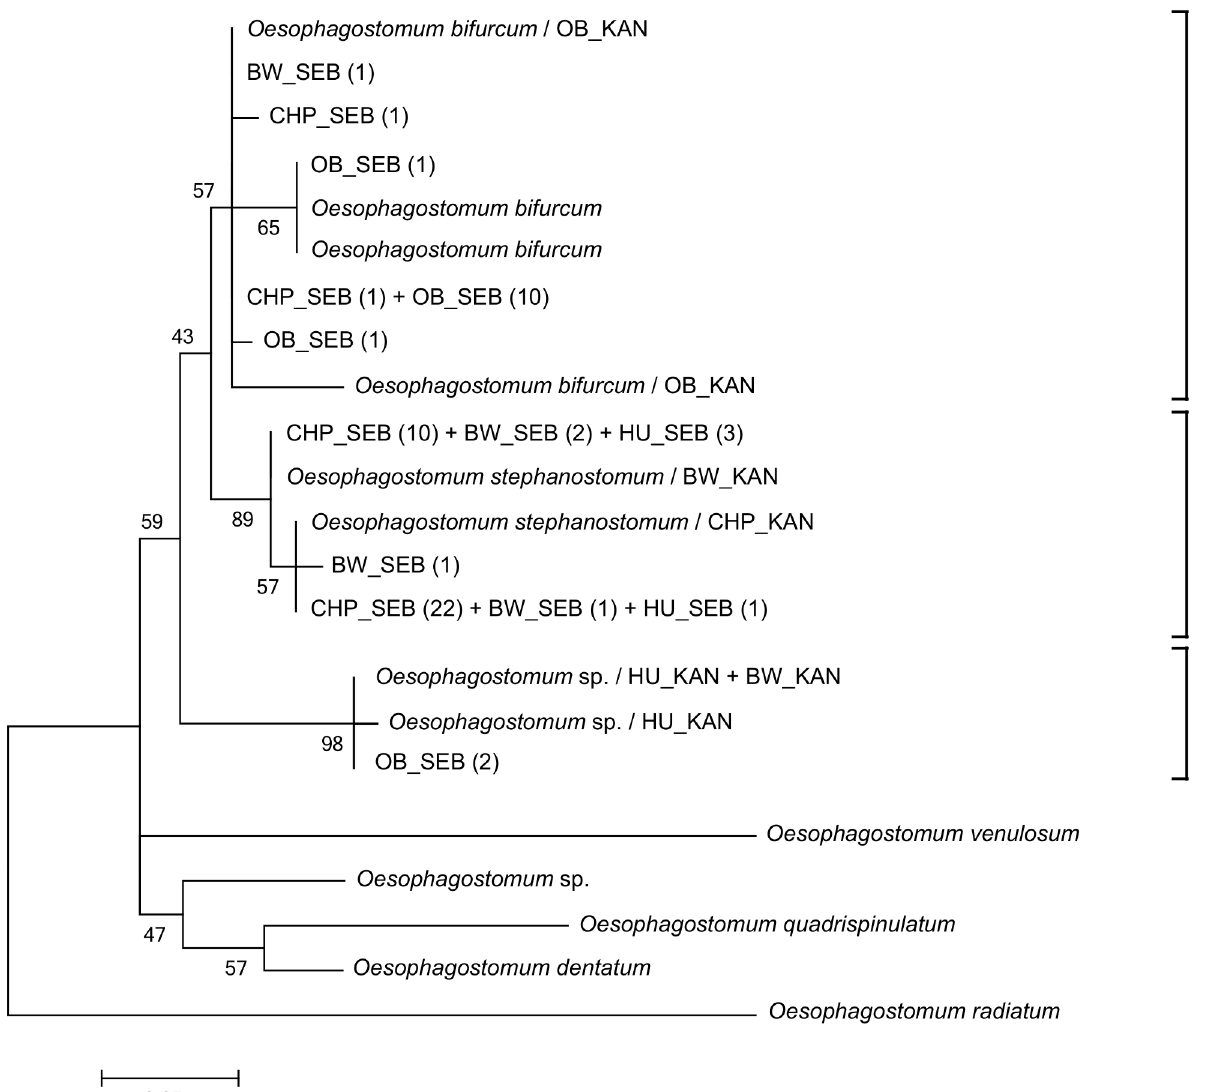
Fig 3. Phylogenetic analysis of Oesophagostomum sp. based on ITS2 rDNA (245 bp) sequences. SEB: Sebitoli samples; KAN: Kanyawara samples (according to [17, 18]); HU: humans; OB: olive baboons; BW: black and white colobus; CHP: chimpanzees. The number of infected fecal samples per host species is shown in parentheses. The scale bar indicates the nucleotide substitutions per site. Bootstrap values are shown as